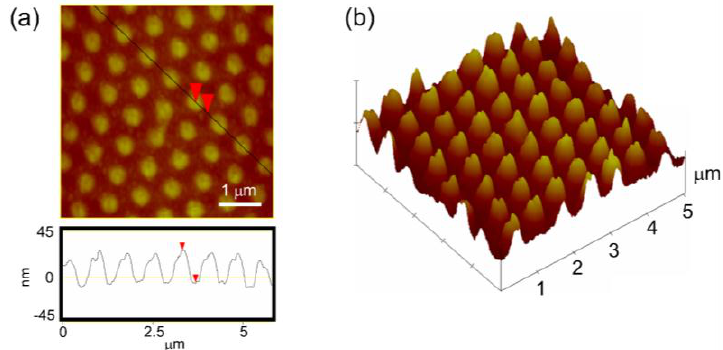
Figure 10. ( a ) Atomic force microscopy (AFM) image of the periodic array of nanocones imprinted on TiO 2 film. The AFM line scan shows the periodicity at ~750 nm and the average height of nanocones at ~35 nm; ( b ) Three-dimensional view of the structure showing titania nanocone arrays.